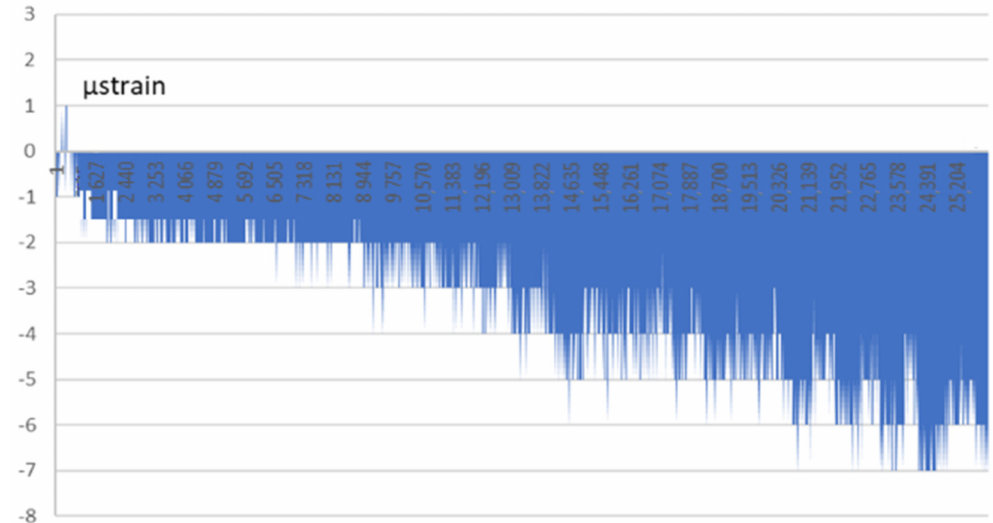
Figure 15. Strain in the building envelope.